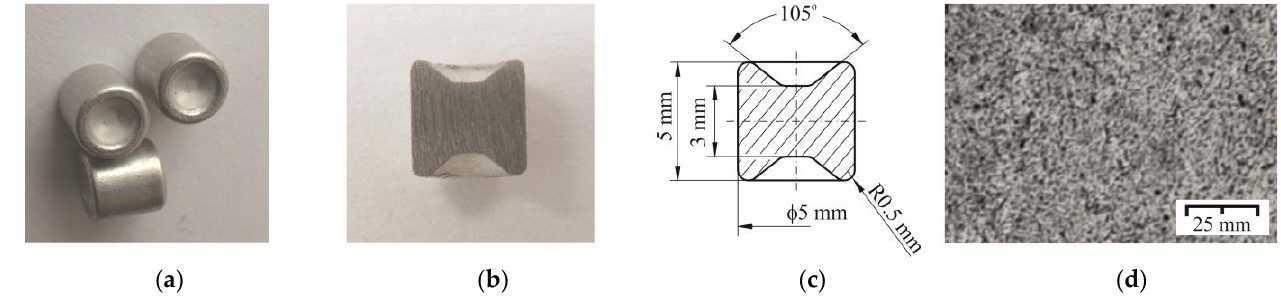
Figure 1. Additional rivets used in clinching forming process: ( a ) real view, ( b ) axial section, ( c ) basic dimensions, ( d ) rivet material microstructure.